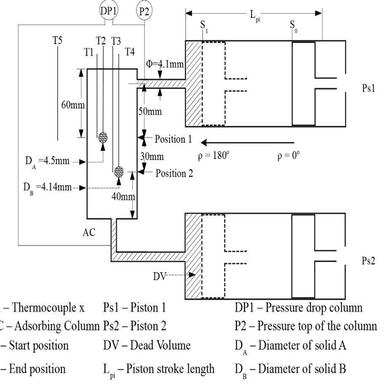
Schematic of the adsorption column and the two pistons showing the dimensions of the system and the locations of the thermocouples and pressure transducers.